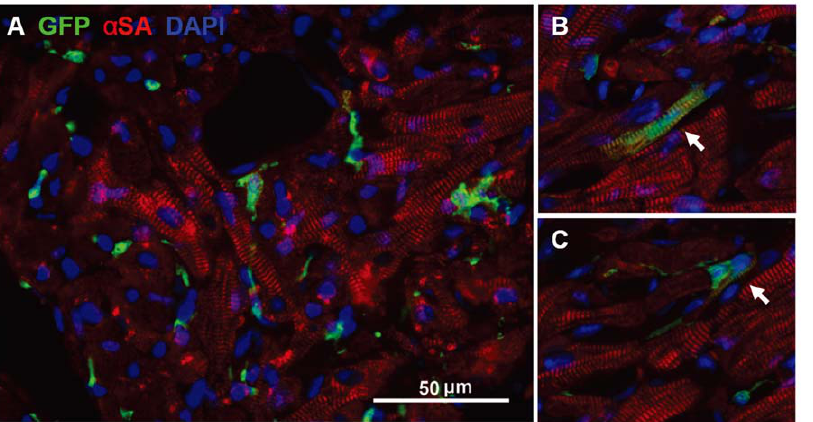
Figure 2. Myocytes transdifferentiation from GFP + bone marrow in fetal heart inside kidney capsule. Immunostaining was performed at 12 months after fetal heart transplantation into kidney capsule and GFP + bone marrow transplantation. A: GFP + circulating cells homed into the fetal heart, which was beating in the kidney capsule. B and C: Two cardiomyocytes (arrows) transdifferentiated from the GFP + bone marrow-origin cells. Striation structure and co-localization of GFP (green) and a -sarcomeric actin (red) are evident.